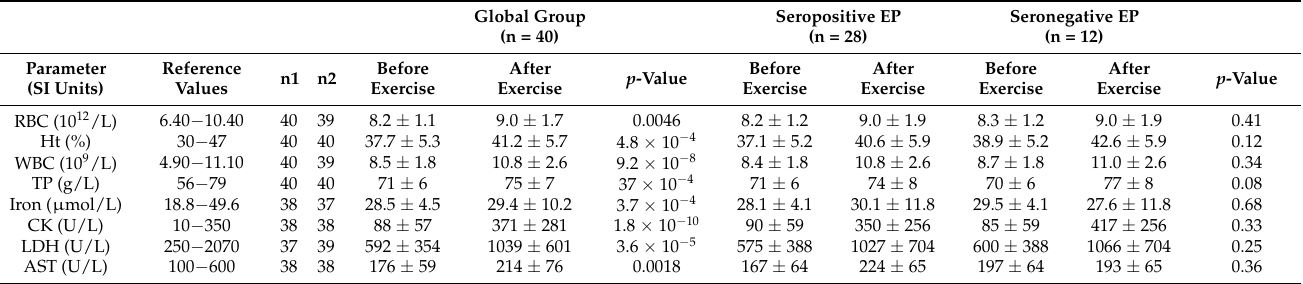
Table 1. Summary of mean ± standard deviation (SD) of hematologic and biochemistry parameters values depending on the presence of equine piroplasmosis (EP) and performance of the